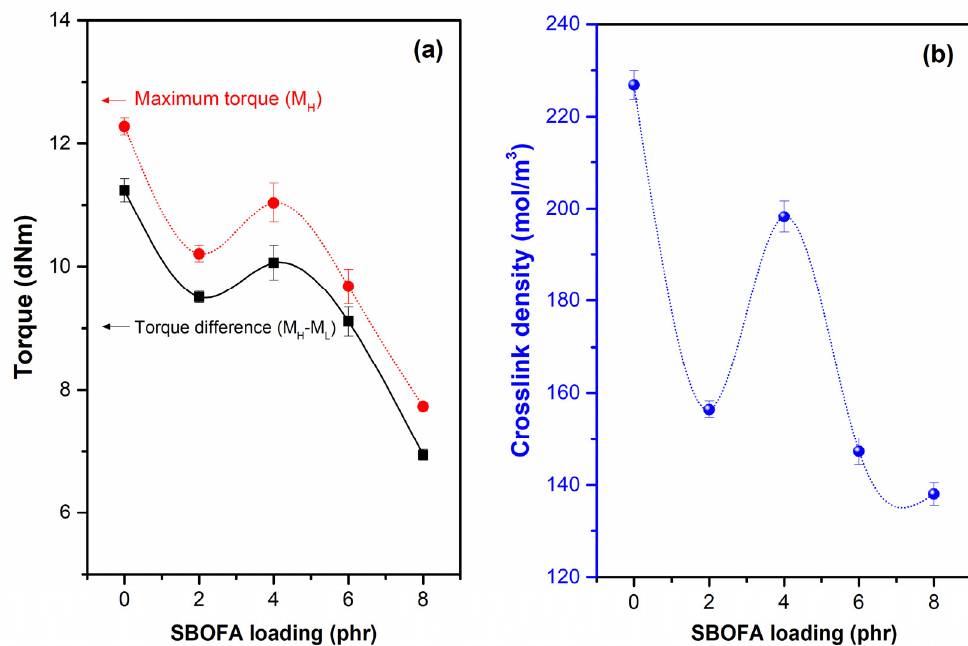
Figure 8. The ( a ) maximum torque (M H ) and torque difference (M H -M L ) and ( b ) crosslink density of NBR compounds with varying SBOFA loadings. Data are shown as the mean ± 1 SD, derived from three experiments.